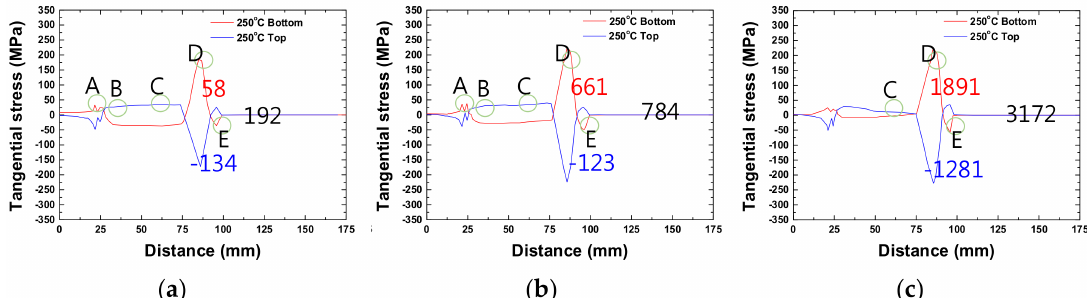
Figure 7. The tangential stress values at the top and bottom layers of the blank (under isothermal condition) for punch speeds of ( a ) 1, ( b ) 5 and ( c ) 10 mm/s at 250 ◦